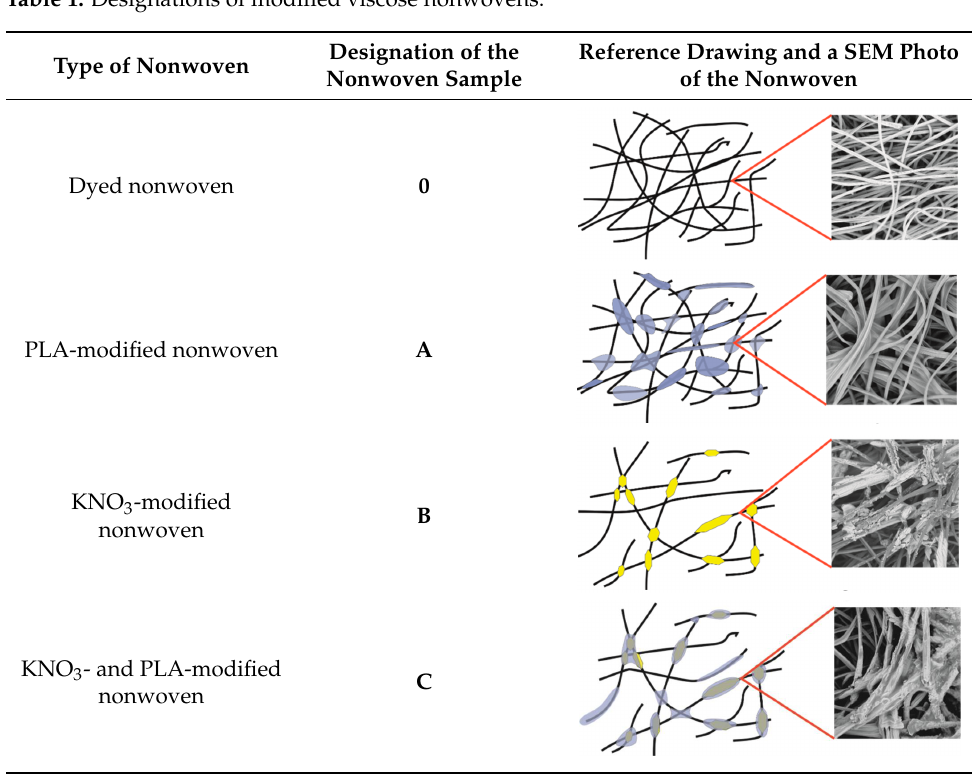
Figure 2. Diagram of the viscose nonwoven C modification process. 2.3. Properties of Nonwovens In order to determine the properties of the nonwovens obtained in the experiment (samples: 0; A; B; C), the following tests were carried out: surface mass, air permeability, perpendicular water permeability, breaking force and relative elongation. In the case of nonwoven C, which was selected and used in the 15-week cycle of to- mato cultivation, every two weeks, the appropriate number of samples for testing was taken, air-dried, and then soil remnants and other contaminants were removed using compressed air. The samples purified in this way were subjected to the same tests as de- scribed above [25]. First, the surface mass of the nonwovens was determined. For this purpose, samples with dimensions of 15 × 15 cm were weighed using SARTORIUS CP224S-0CE analytical balance with an accuracy of 0.0001 g. The surface mass (Ws) of the nonwovens (g/m 2 ) was calculated according to the following formula: